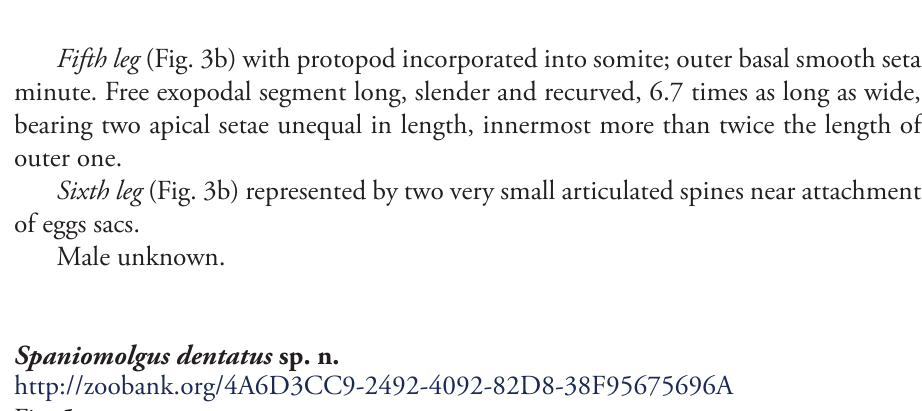
Type locality. Saudi Arabian Red Sea, reef near Thuwal, 22°03'48.5"N,